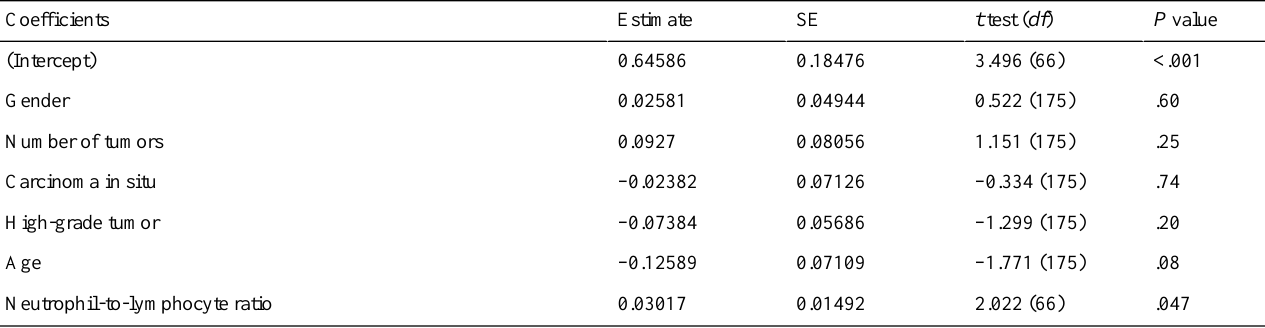
Table 4. Coefficients from multivariate regression with Club Urológico Español de Tratamiento Oncológico scoring model elements.